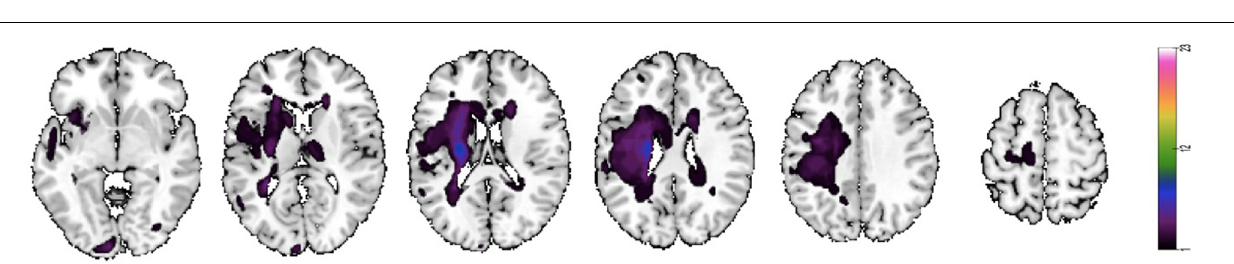
FIGURE 2 | Lesion map of individual stroke lesions. Lesion overlap map of individual lesions in patients with stroke. Maps are overlaid on a T1 template in MNI space. Lesions in the right hemisphere were flipped to the left hemisphere. MNI coordinates of each transverse section ( z -axis) and a sagittal slice for visualization are given. Color scale indicates the number of patients with a lesion in a given